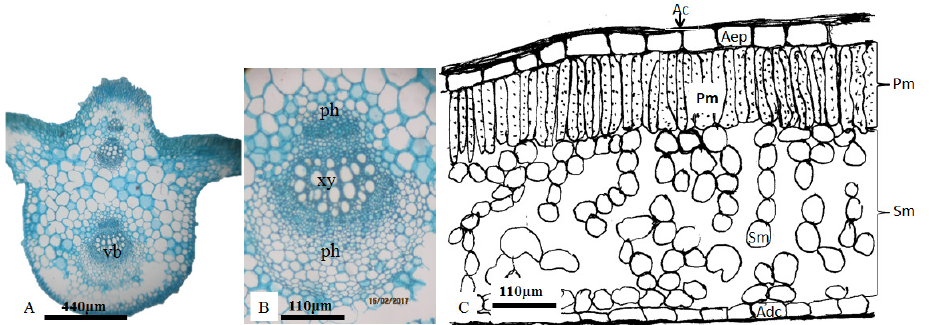
Fig. 5. Anatomy of B. hispida (A and B) midrib and (C) leaf lamina (vb = vascular bundle, xy = xylem, ph = phloem, Ac = adaxial cuticle, Aep = adaxial epidermis, Pm = palisade mesophyll, Sm = spongy mesophyll, Adc = abaxial epidermis)